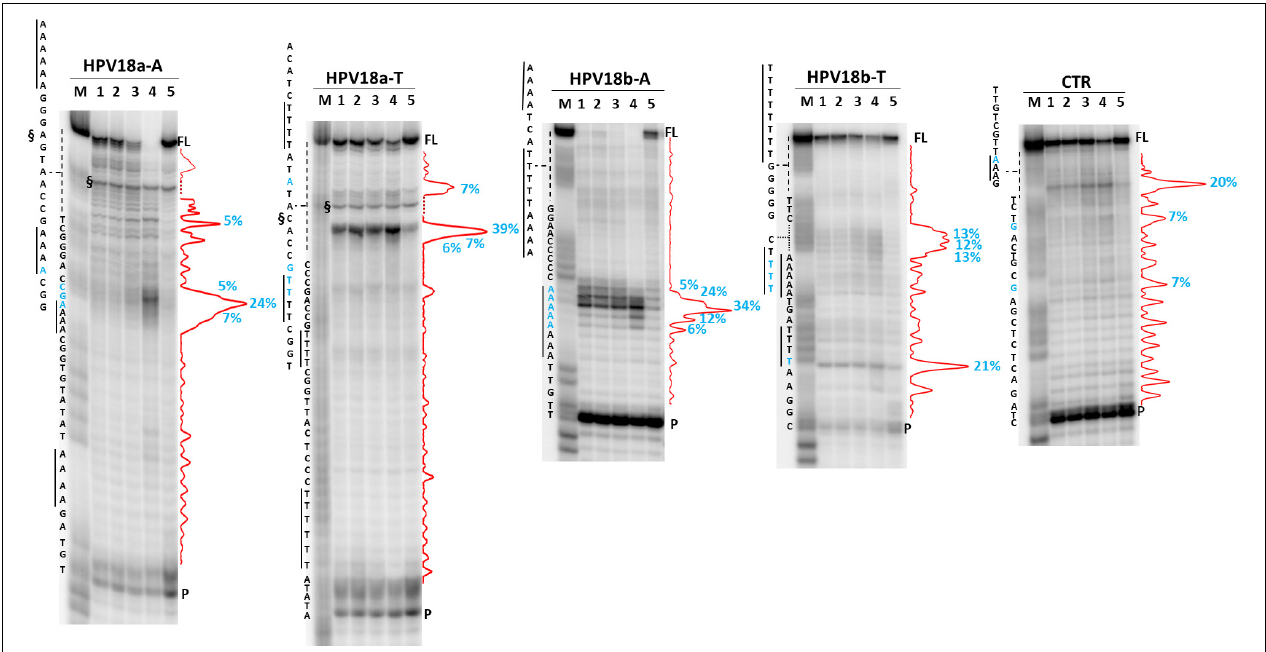
FIGURE 8 | Taq polymerase stop assay on HPV-18 sequences. Analysis was performed in the absence (lane 5) or presence of 100 mM different salt types, such as KCl (1), NaCl (2), LiCl (3), and NaF (4). M indicates a sequence marker lane, obtained by the Maxam and Gilbert sequencing protocol; P indicates the unreacted labeled primer; FL indicates the full-length elongation product; § indicates primer dimer band and was excluded from quantitation (dotted line). Red densitograms show stop bands quantification. Percentages of peaks ( ≥ 5%) are reported in blue, along with the corresponding nucleotide. Elongation was performed at 37 ◦